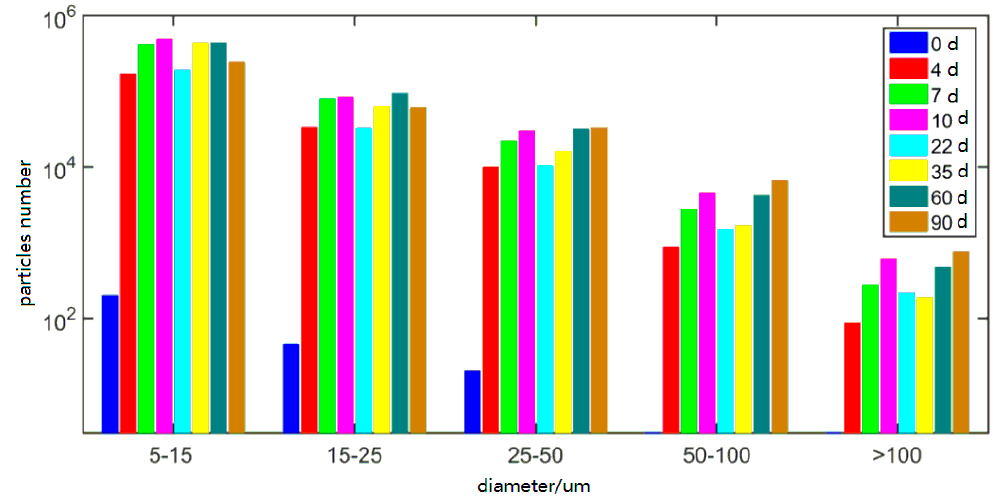
Figure 2. Particle size distribution of fibers in oil with different aging days at 130 °C.